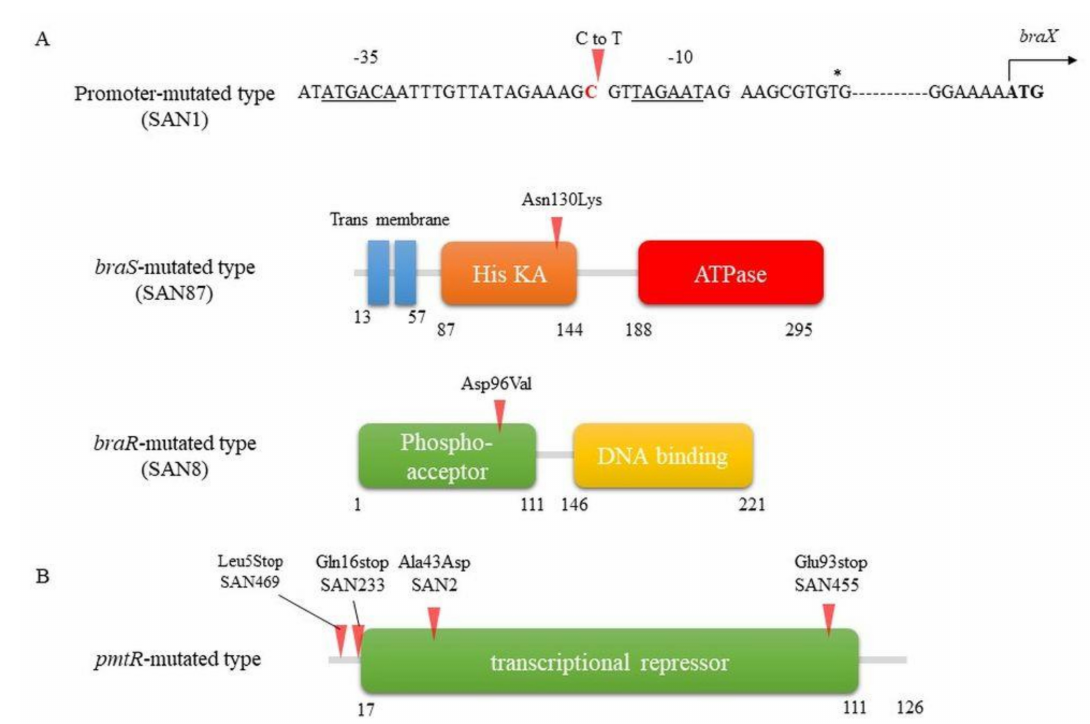
Figure 3. Mutation sites in the high nisin A-resistant strain. ( A ) Mutation sites in the braXRS region. The mutation sites in the braXRS region in the isolated mutants are indicated by red arrows. The nucleotide sequence upstream of braXRS in the MW2 strain is shown, with the –35 and –10 regions indicated by the underline. The transcription initiation start sites are labelled with an asterisk, and the ATG translation initiation codons are indicated in bold. Mutation sites in SAN1, SAN87, and SAN8 are found in the braXRS promoter region (upper), His KA of braS region (middle), and phospho-acceptor domain of braR region (lower), respectively. His KA, dimerisation and phospho-acceptor domain of histidine kinases. ( B ) Mutation sites in the pmtR . The pmtR in MW2 strain is shown. In the isolated mutants from MW2 (SAN2 and SAN469), COL (SAN233) and TY34 (SAN455) strains, all mutations were found within the pmtR (red arrows).